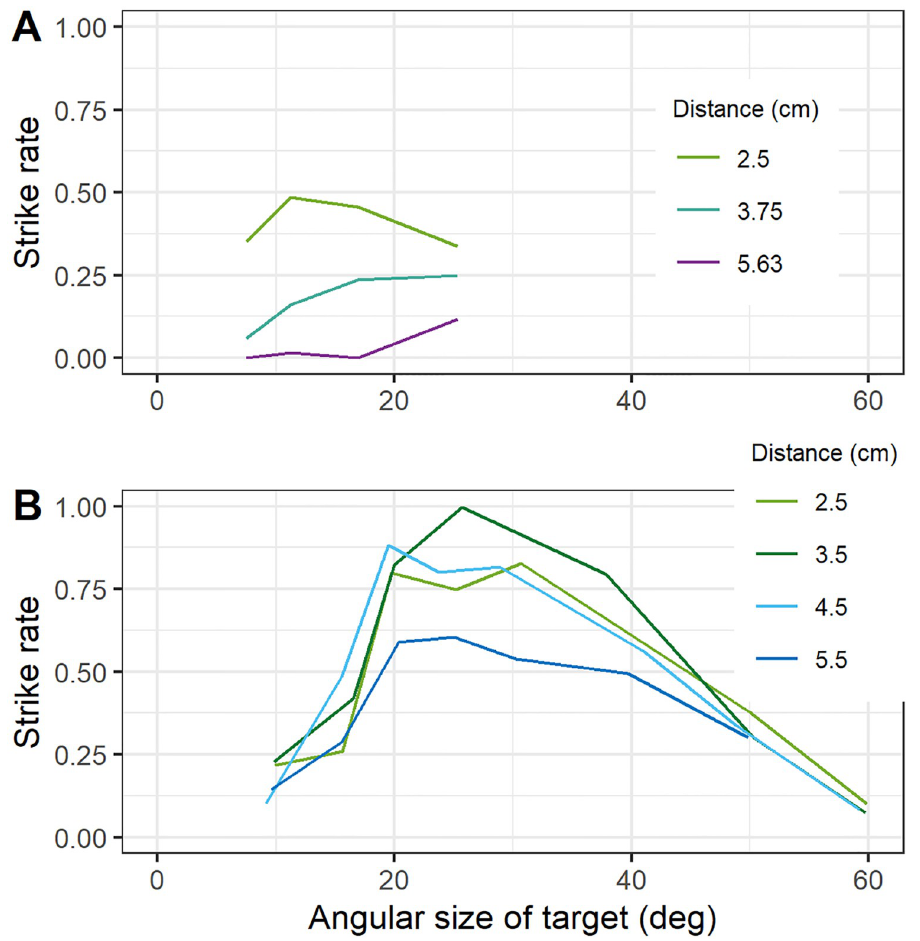
Fig 4. Sensitivity of mantis striking behaviour to stimulus size and stereoscopic distance. (A) Data from [10], available at http://dx.doi.org/10.1098/rstb.2015.0262. Species was Sphodromantis lineola ; stimuli were on a computer screen 10cm from the insect; nearer distances were simulated using coloured filters. (B) Data extracted from Fig 5 of [36] using WebPlotDigitiser (https://apps.automeris.io/wpd/). Species was Sphodromantis viridis ; stimuli were on a computer screen 5.5cm from the insect; nearer distances were simulated using base-out prisms. Note that in this figure, we plot the strike rate, i.e. the probability that a given trial elicits striking behaviour (since this was what was available for [36]). In [10], some trials elicited several strikes. The peak strike rate in A, 0.49, is lower than the peak of the mean number of strikes, plotted below in Fig 9.